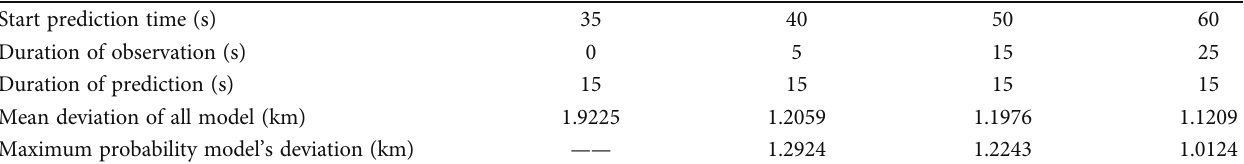
Figure 6: The amount of deviation in the prediction of the trajectory corresponding to di ff erent time lengths. (a) No observation and tracking. (b) Track and identify for 5 s. (c) Track and identify for 15 s. (d) Track and identify for 25 s. Table 1: Accuracy analysis of trajectory prediction method (the terminal time is